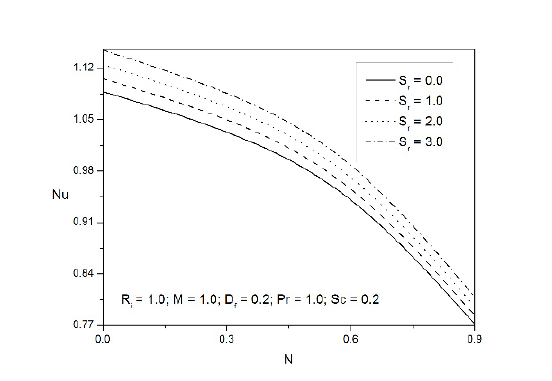
Figure 16. Effect of Dufour number D